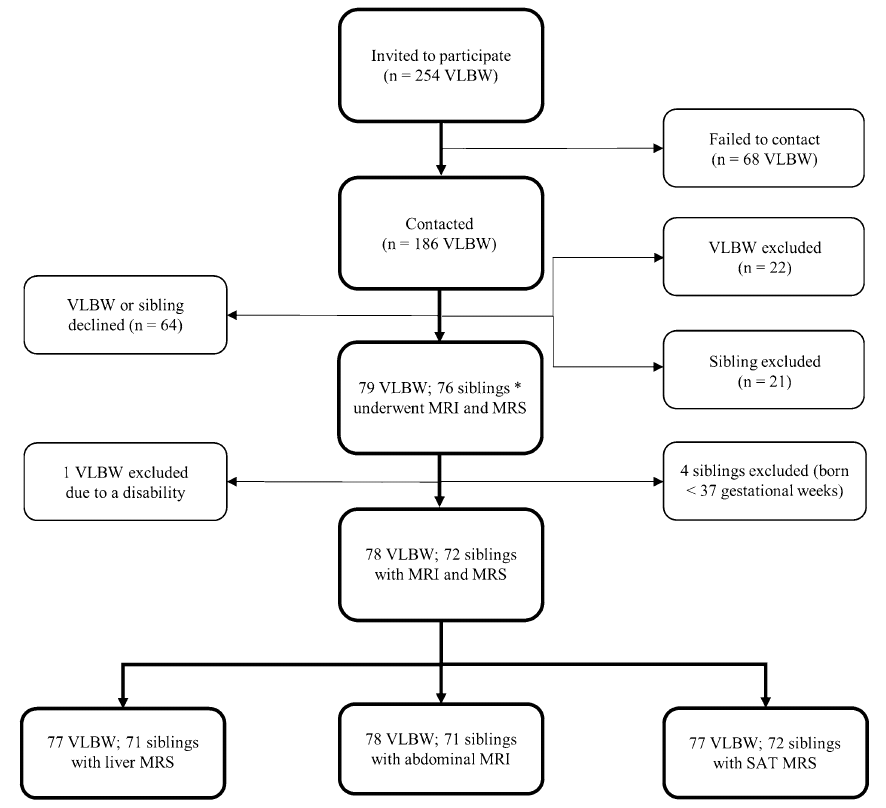
Figure 1. Flowchart of the data collection process. VLBW: very low birth weight, < 1500 g. MRI: magnetic resonance imaging. MRS: magnetic resonance spectroscopy. SAT: subcutaneous abdominal adipose tissue. * three siblings withdrew initial